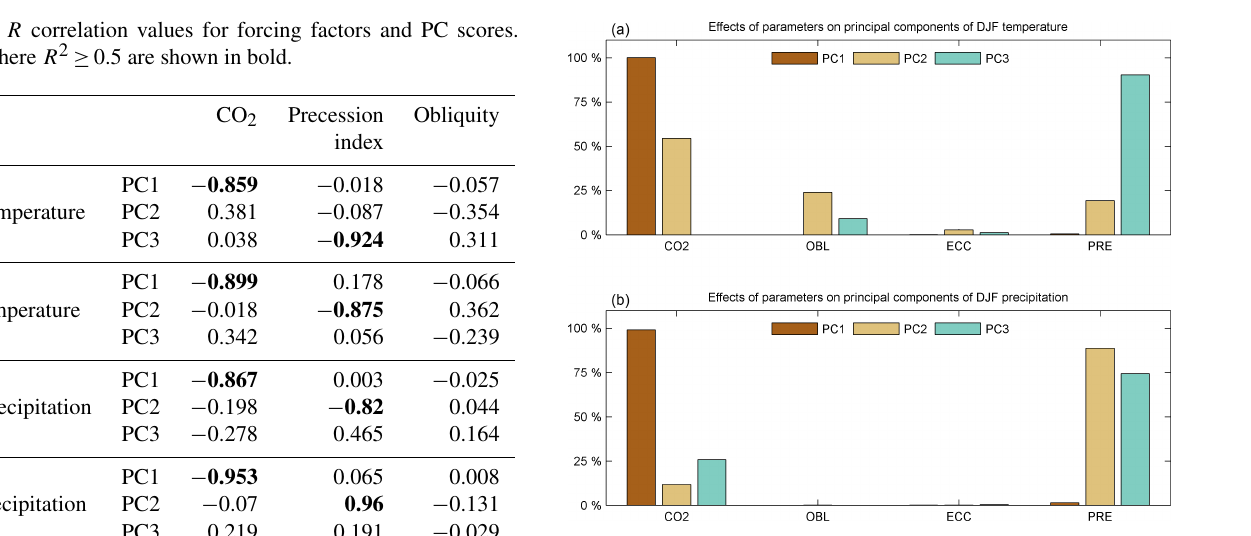
Figure 10. Main effects of forcing parameters on the first three principal components of DJF temperature (a) and DJF precipitation (b)